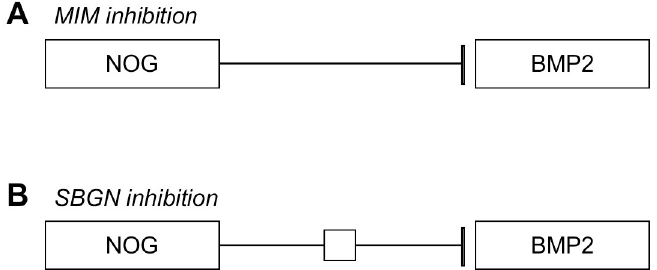
Fig 1. Differences in drawing of MIM vs SBGN inhibition interaction. A shows a MIM—inhibition interaction. B shows a SBGN—inhibition